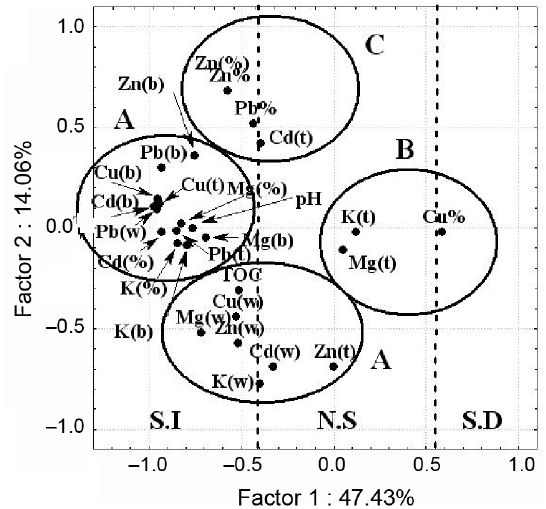
Fig. 7. Relation between Factor 1 and Factor 2 (Variables). A (first group, TOC, Cu(w), Mg(w), Zn(w), Cd(w), K(w) and Zn(t)), B (second group, Mg(t), K(t) and Cu%), C (third group, Zn%, Pb% and Cd(t)) and D (fourth group, Zn(b), Pb(b), Cu(b), Cu(t), Cd(b), Pb(w), Cd%, K%, Pb(t), Mg%, pH, K(b) and Mg(b)). SI (Significant differences between sites, major con- centration in contaminated plot), N.S. (non-significant differen- ces between plots) and S.D. (Significant differences between sites, major concentration in control plot